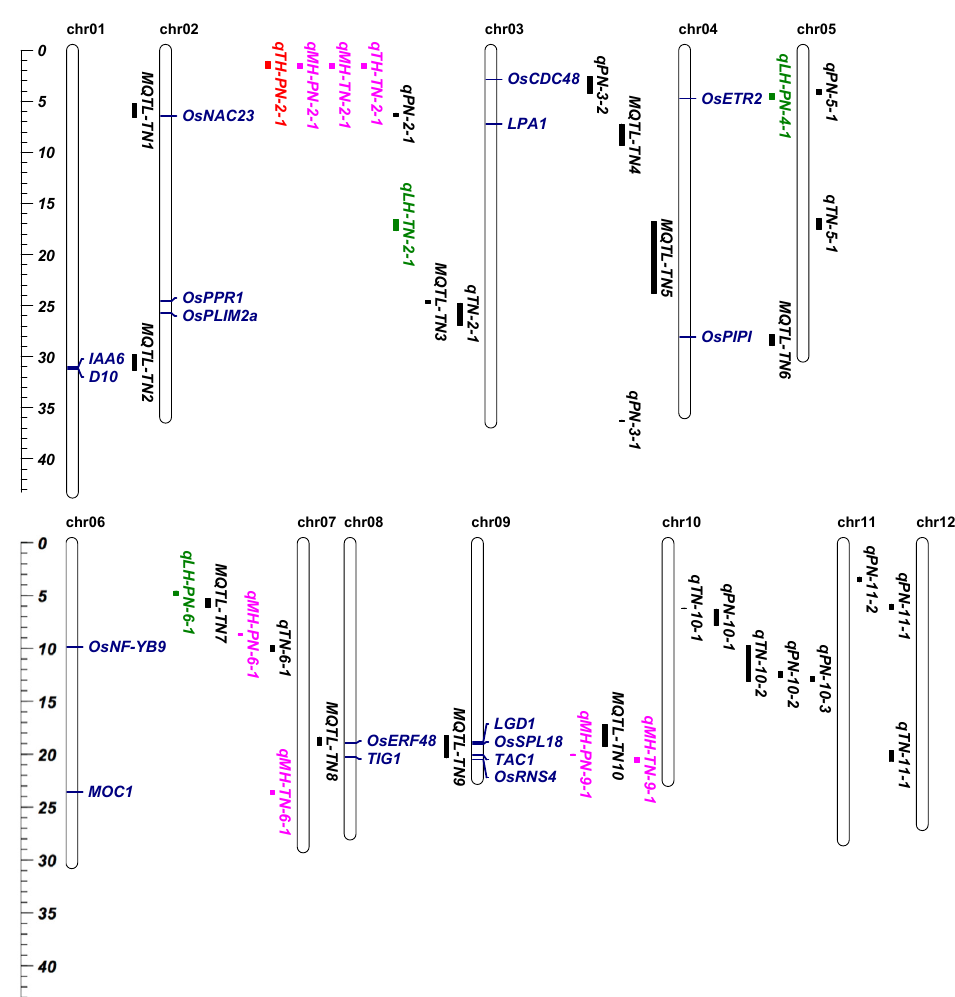
Figure 5. The position of the quantitative trait locus (QTLs) for effective panicle numbers (PN), tiller numbers (TN) in recombinant inbred lines (RILs) and heterosis-related QTLs in two testcross hybrid populations, and the location comparison of them and MQTLs. The QTLs and heterosis-related QTLs located in this study are labeled on the right side of the chromosome; black represents the QTLs and MQTLs. Green, pink, and red represent the relative low-parent, middle-parent and transgressive heterosis-related QTLs, respectively. Blue represents the known genes, covered by QTLs, MQTLs and heterosis-related QTLs. The Y -axis represents the physical distance (Mb) of the